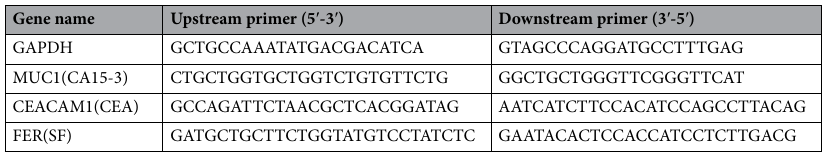
Table 6. PCR primers used in the present